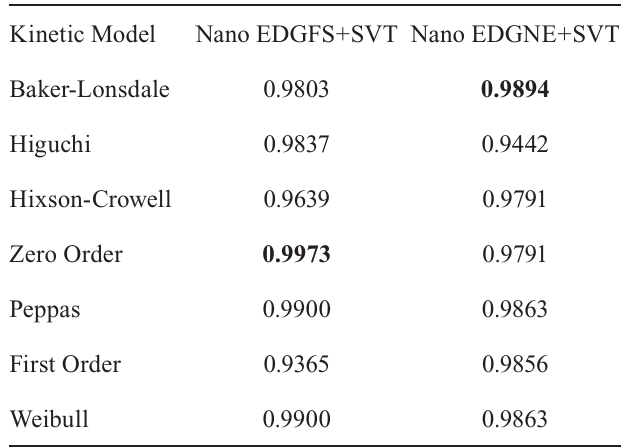
Determination Coefficient